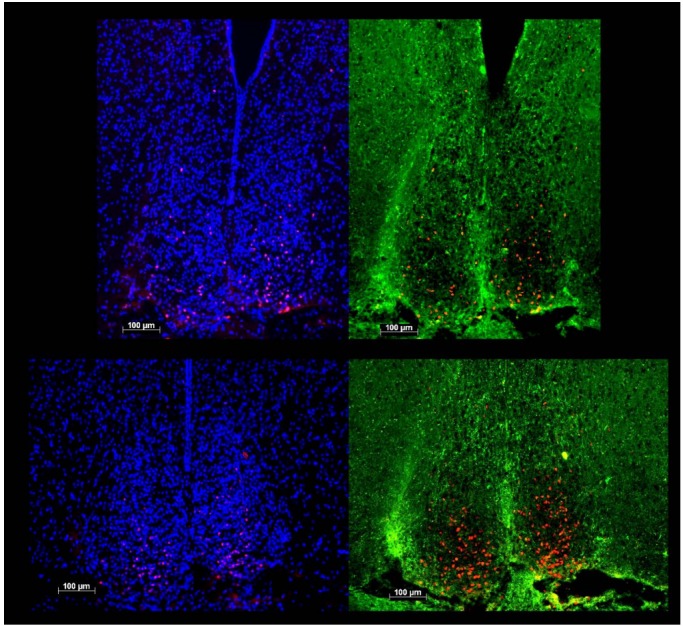
DOI:
http://dx.doi.org/10.7554/eLife.23292.023